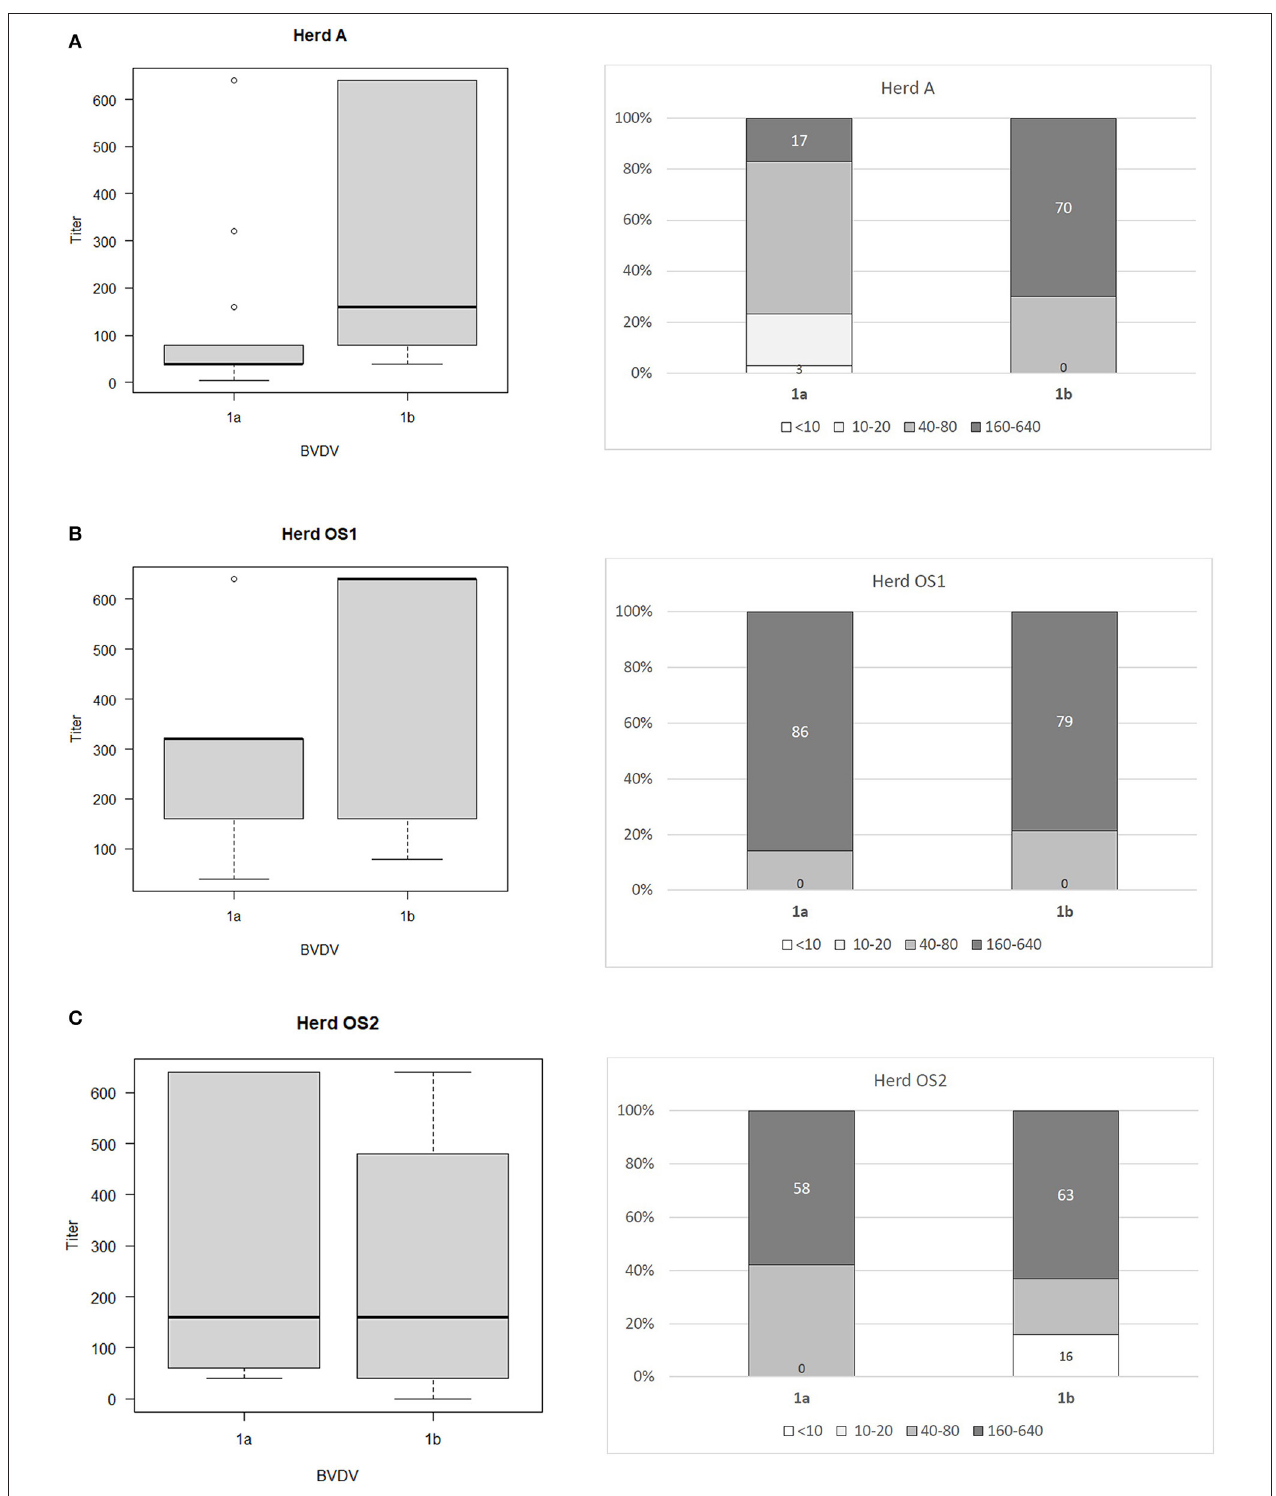
FIGURE 1 | Box and whiskers plots of antibody titers juxtaposed with percentages of antibody titers against BVDV-1a and BVDV-1b for herds where PI animals infected with BVDV-1b were identified: (A) herd A, (B) herd OS1, (C) herd OS2. The top and bottom of boxes represent 25th and 75th percentiles, respectively; the middle line represents the median value, whiskers represent the highest and lowest values which are not outliers, outliers are indicated as circles. In a percentage graph, samples were classified as negative (VN titers up to 10), low (titers between 10 and 20), medium (titers between 40 and 80), and high (titers between 160 and 640) titer samples. Numbers refer to percentages of negative and high titer